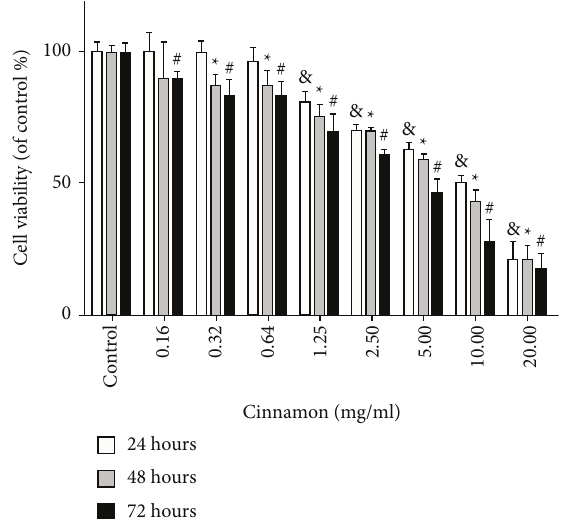
Figure 1: Effect of different concentrations of Cinnamon aqueous extract on 5637cell viability. 5637cell were treated with concen- trations (0.16, 0.32, 0.64, 1.25, 2.50, 5, 10, and 20mg/ml) for 24, 48, and 72h Results are expressed as mean ± SD and each value is the average of at least three independent replicates. & denoted the significant difference in comparison with the control group in 24 h ( P < 0 . 05), ∗ in 48 h ( P < 0 . 05), # in 72h. ( P < 0 . 05) compared to the control